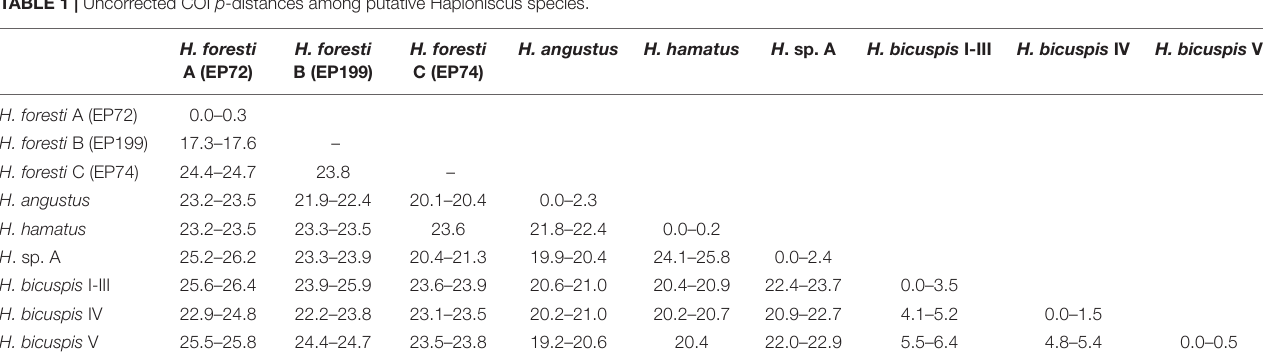
FIGURE 6 | Bayesian phylogenetic tree of COI. Posterior probabilities are shown on branches. The colored circles show delimited putative species. The inner circle corresponds to ASAP and single threshold GMYC, the outer to multiple threshold GMYC. TABLE 1 | Uncorrected COI p -distances among putative Haploniscus